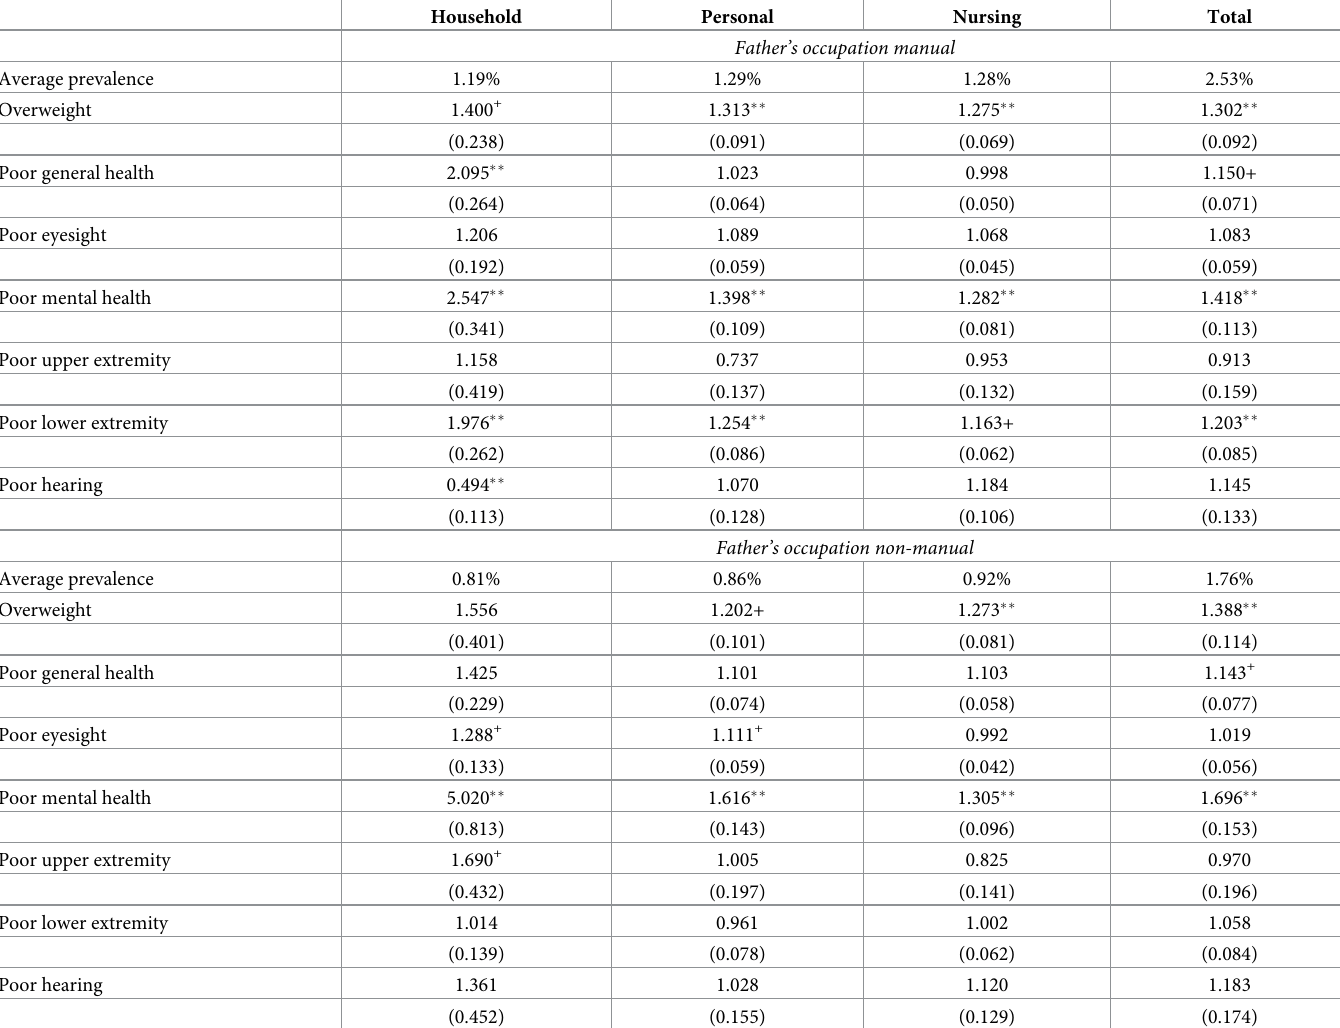
Table 4. Odds ratios panel probit model of early life health on later life home care use accounting for selective survival, manual vs non-manual father’s occupation